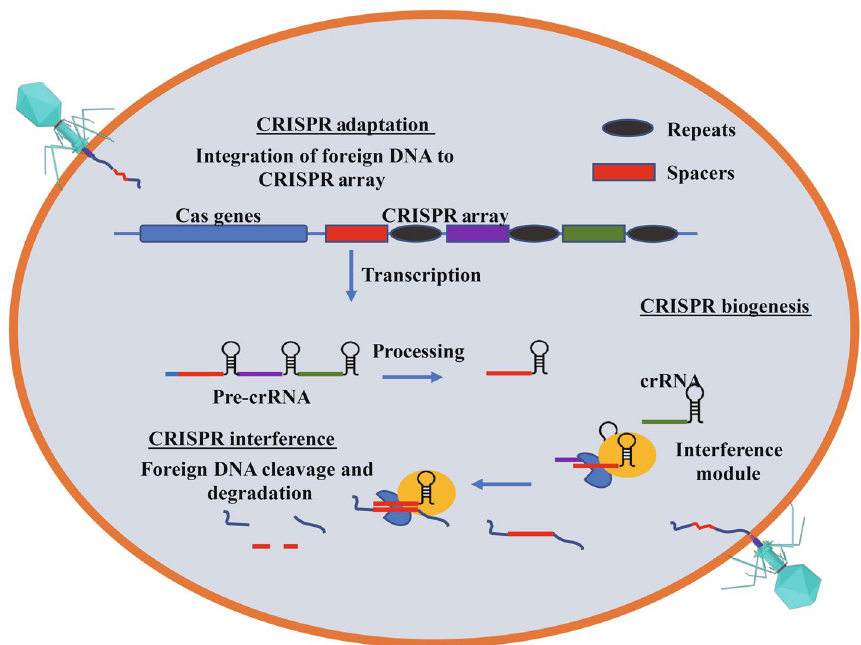
Fig. 1 The CRISPR-Cas adaptive immunity. During adaptation phase Cas1-Cas2 complex selects spacer and incorporates to the upstream of CRISPR locus. At crRNA biogenesis phase, the locus transcribes pre-crRNA which forms tracr-RNAs that helps in the recognition by RNase III and cutting process during the interference